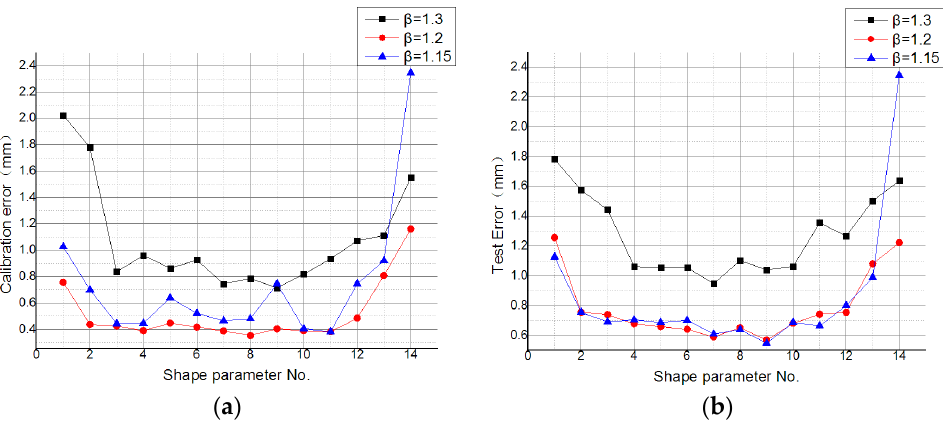
Figure 9. Calibration error and test error of the MQ function with different values of the shape parameter in different partition of unity for the ( a ) calibration data set and ( b ) test data set.